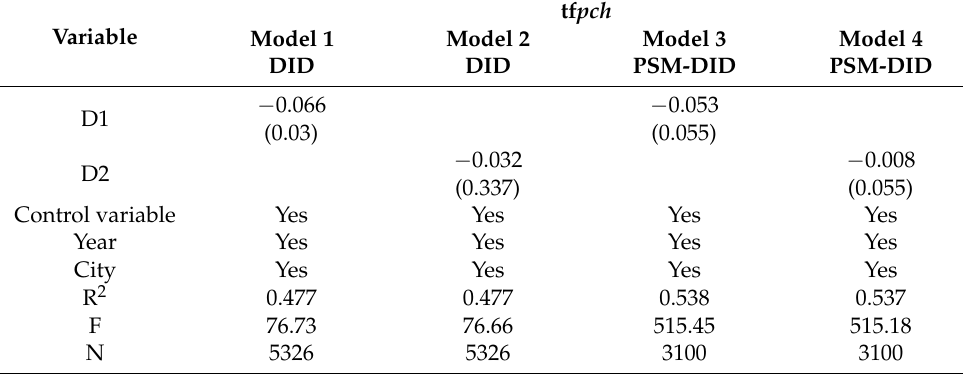
Table 5. Placebo